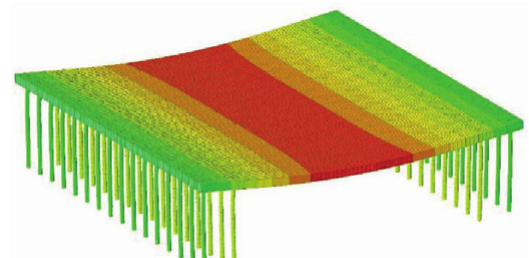
fig. 6. Spatial numerical model of the piled raft for variant II, general deformable view